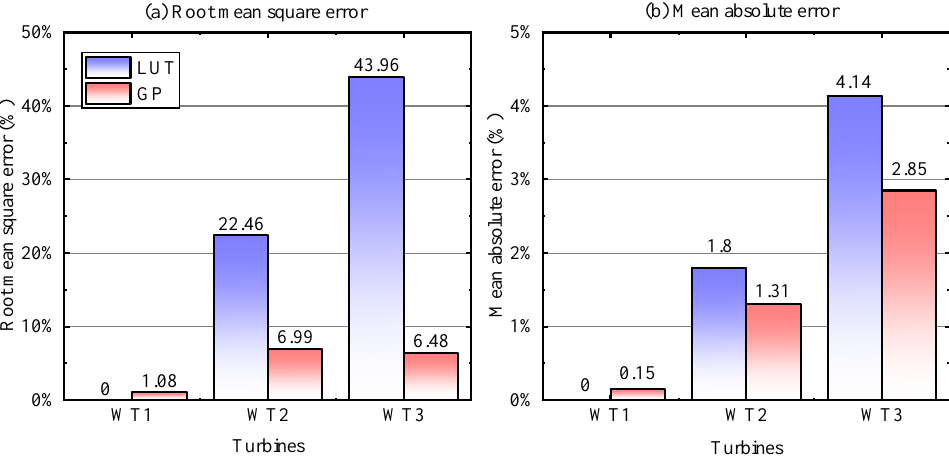
Figure 17. RMSE and MAE error of GP and LUT predictions on blade root flapwise